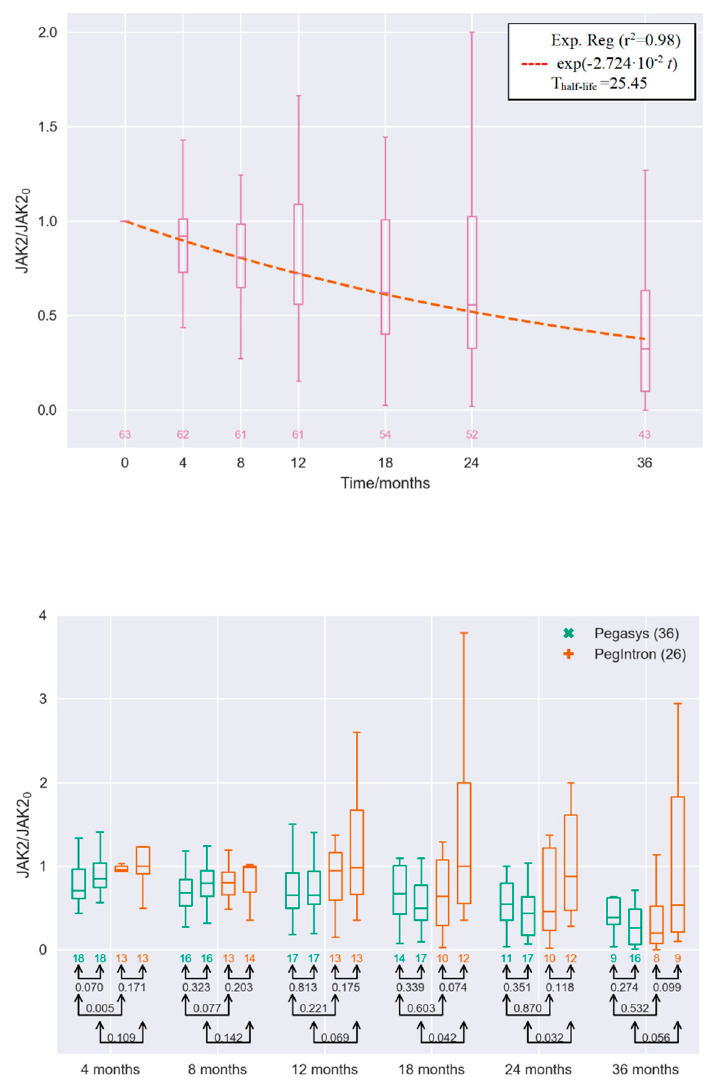
Figure 1. Top panel: JAK2 V617F allele burden measurements for all the interferon- α 2 (IFN)-treated myeloproliferative neoplasms (MPN) patients in the DALIAH trial normalized with their respective baseline value denoted JAK2 0 at the secondary axis (see Section 4: Materials and Methods). Median values fitted with exponential decay reveal that the JAK2 V617F allele burden is halved every 25 months on a population level. Bottom panel: Boxplot showing the medians and percentiles of the JAK2 V617F allele burden measurements for the IFN-treated MPN patients in the DALIAH trial normalized with their respective baseline values (see Section 4: Materials and Methods). Boxplot values are depicted for each visit in the clinic—i.e., at months 4, 8, 12, 18, 24, and 36, where all have the normalized value 1 at baseline. For each visit, the leftmost is for the cohort receiving Pegasys and of an age below 60, whereas the next (the second from left) is for the cohort receiving Pegasys and of an age 60 or above (both groups in green). The next two are for the cohorts receiving PegIntron of an age below 60 (the third from the left) and the cohort receiving PegIntron of age 60 or above (the rightmost) (both groups in red). Only patients with more than three observations are included. Below each boxplot, the number of patients is shown, whereas connected pairs of arrows and the numbers in black represent the p -value in a Welch’s unequal variances t -test for the equality of